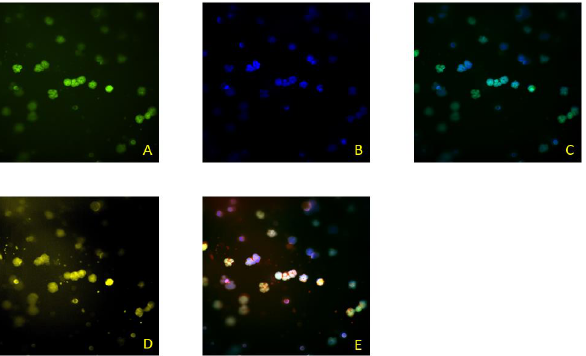
Figure 4. ScreenCell ® — CTCs were IF stained with anti-pan-CK antibodies (green, ( A )); DAPI staining was performed for nuclei staining (blue, ( B )); composite of ( A , B ) micrographics ( C ); leucocytes IF stained with anti-CD45 antibodies (yellow/red, ( D )); and a composite of ( A , B , D ) micrographics ( E ).